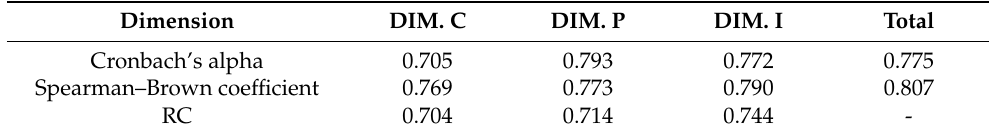
Table 3. Reliability